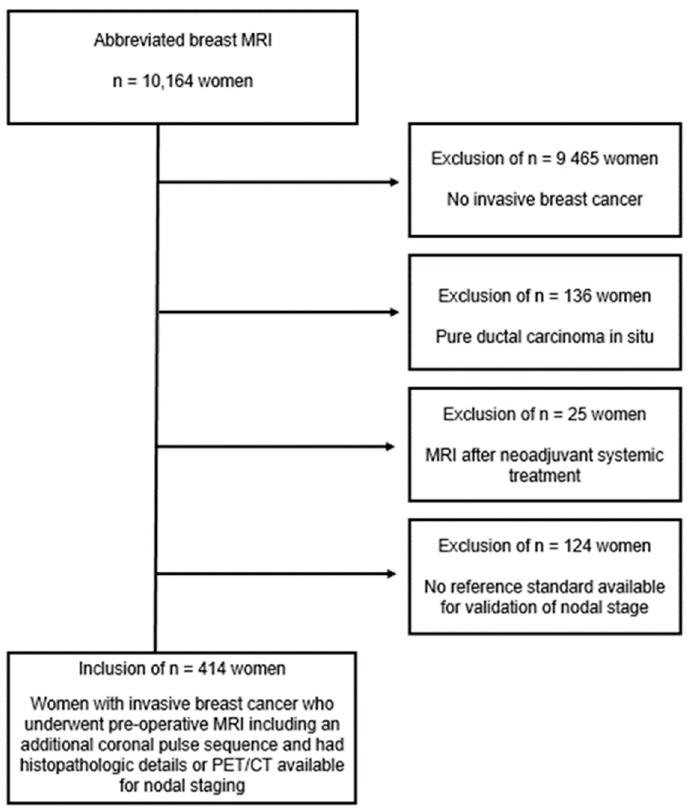
Figure 3. Flow diagram of the study inclusion procedure.